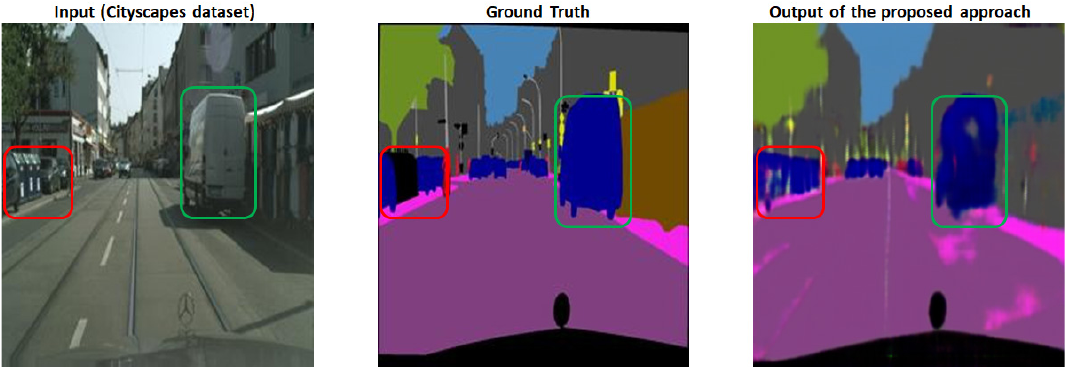
Figure 9. Evaluating the stability and accuracy of the consistent image-to-image translation network, where the balanced training results in stable learning that generates more accurate